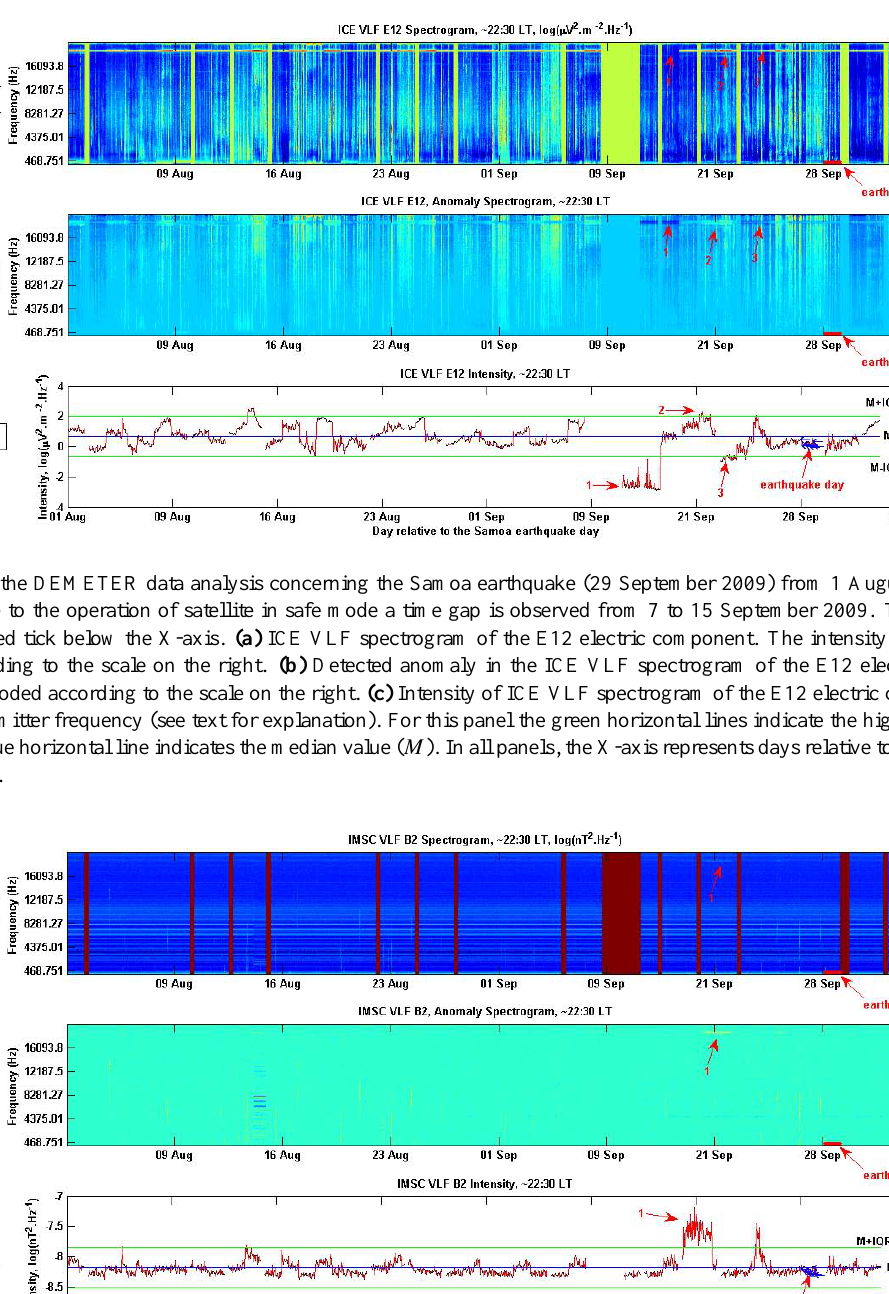
the applied anomaly detection method (Fig. 2b). In order to do better analysis, for each spectrogram the median of the registered transmitter intensities in a frequency range around 18.6 kHz have been calculated. Figure 2c represents the time series of the calculated median of the transmitter signal ac- cording to the spectrogram time scale. The green horizontal